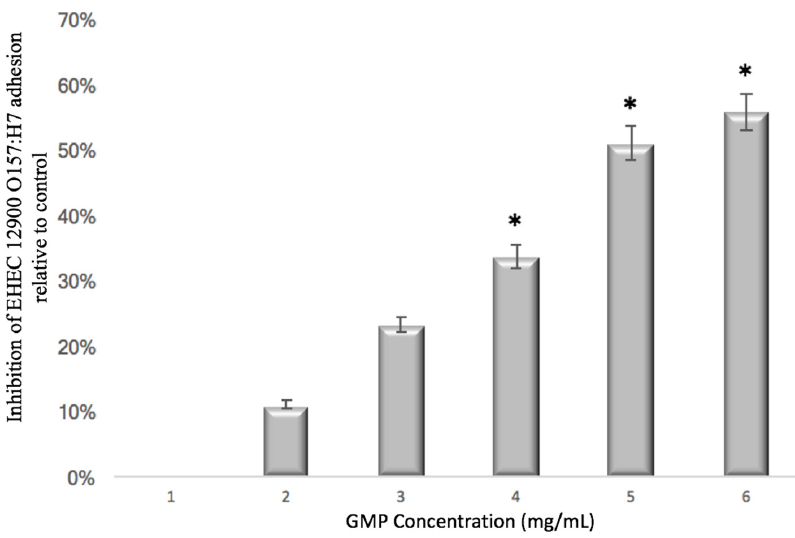
Figure 1. The effect of GMP concentration on inhibition of adhesion of EHEC 12900 O157:H7 to HT-29 cells (* p < 0.05). EHEC = enterohemorrhagic E. coli ; GMP = Glycomacropeptide.